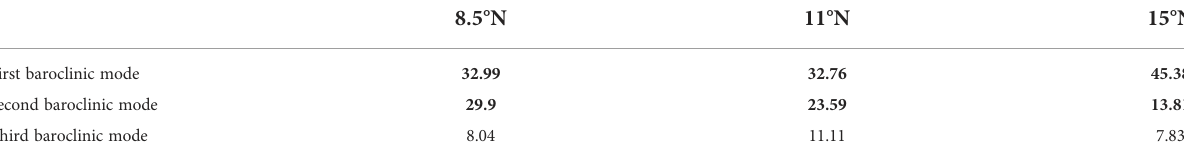
The bold values are to highlight the dominance of the contribution of fi rst and second